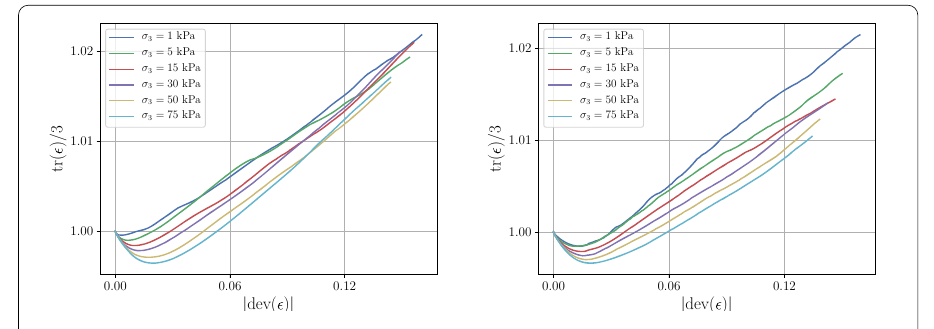
Fig. 7 The volumetric strain as function of the deviatoric strain from triaxial test on gravel-1 (left) and wet-sand-1 (right). The dilatancy angle is measured during the shear failure phase, where the slope is positive and close to linear. It was found ψ gravel-1 = 11 ◦ and ψ wet-sand = 8 ◦ for σ 3 = 15 kPa